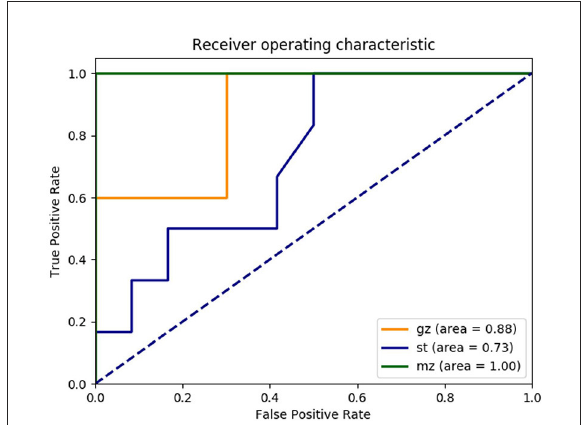
FIGURE6 Receiver operating characteristic (ROC) curves trained on the OTU abundance demonstrate the performance of distinguishing fecal samples from Guangzhou, Shantou, and Meizhou. Yellow line: Guangzhou; blue line: Shantou; and green line: